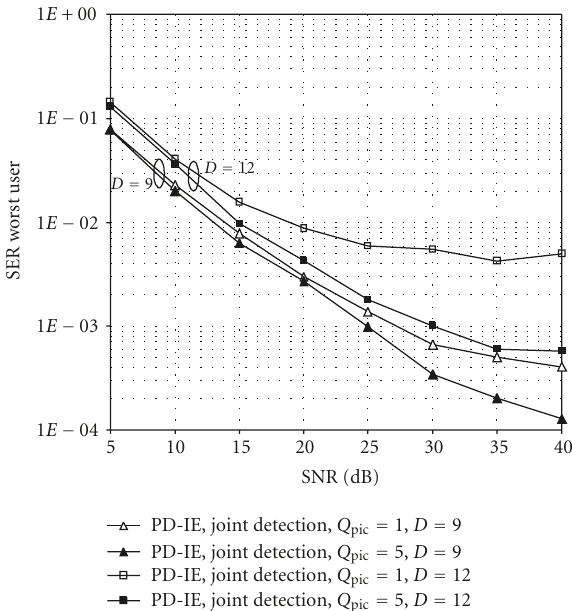
Figure 9: SER of the worst user versus SNR for PD-IE using an M = 6-element ULA with element spacing B = 3 λ . There are D = 9 and 12 cochannel users. The size of the global list S is L = 2 D